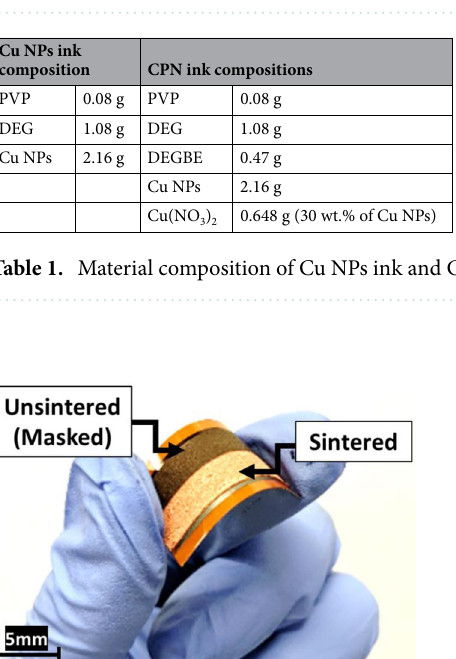
Figure 1. Highly solderable nickel electroplated Cu Precursor/NPs electrode.